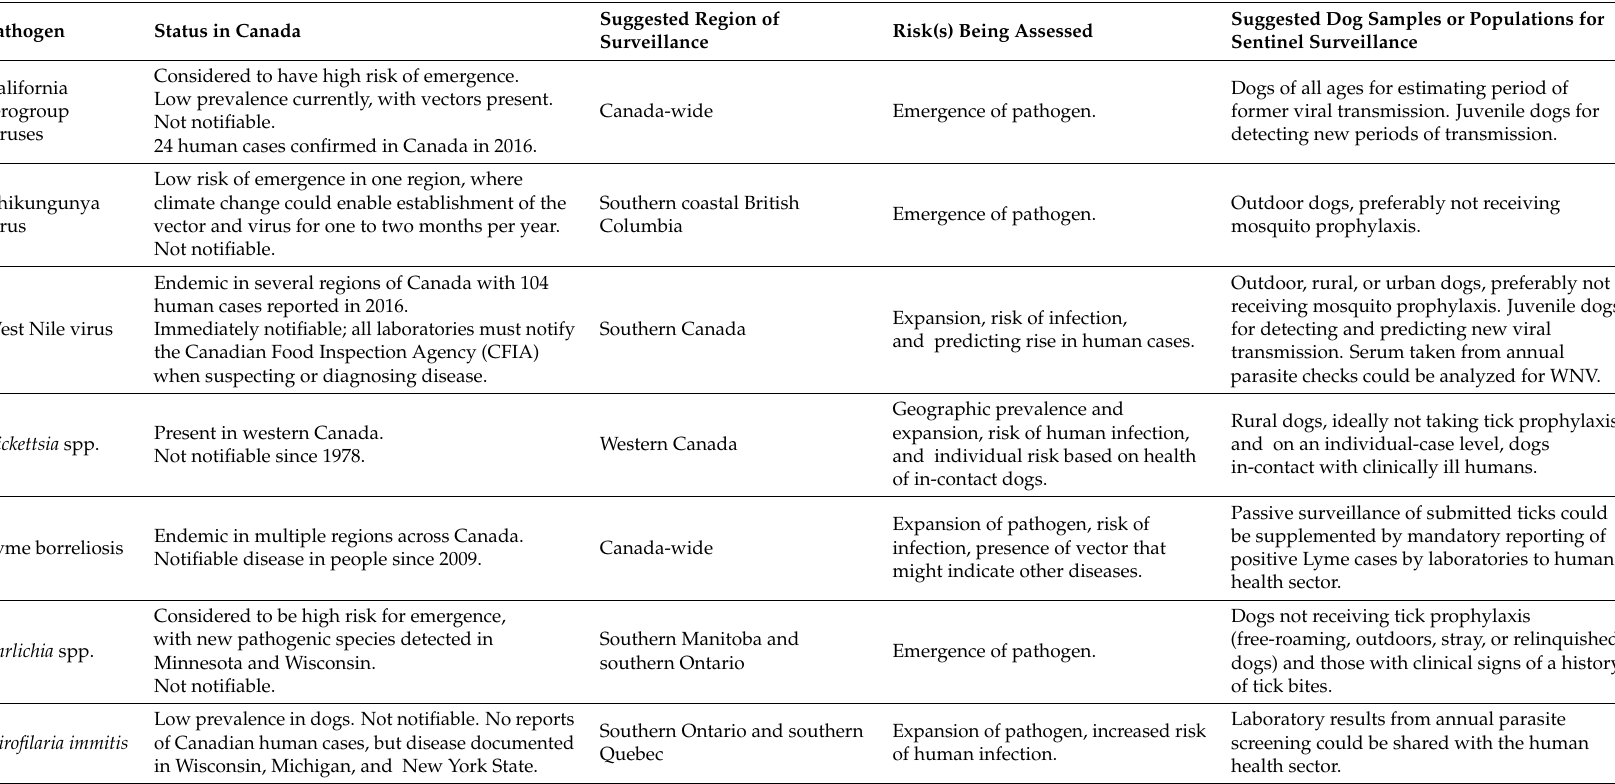
Table 3. Pathogens presenting a risk to Canadians, which could be monitored using dog-sentinel